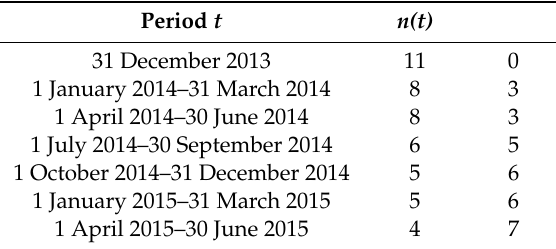
Table 2. List of fit and unfit vehicles from 31 December 2013 to 30 June 2015.